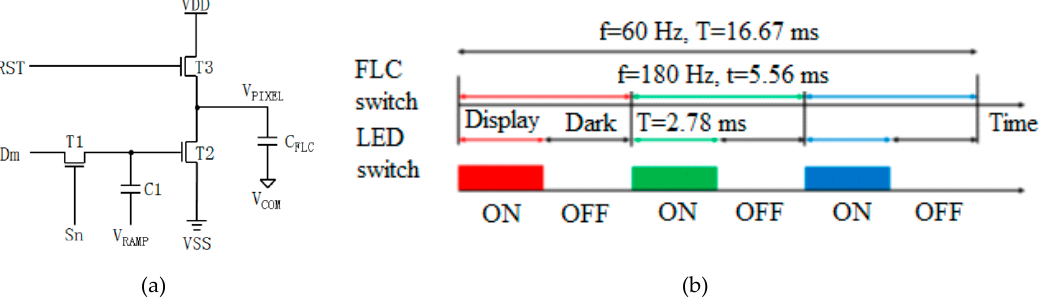
Figure 15. ( a ) The proposed pixel circuit structure for an active matrix ESHFLC to generate gray levels. ( b ) Driving scheme for an active matrix of FSC ESHFLC.